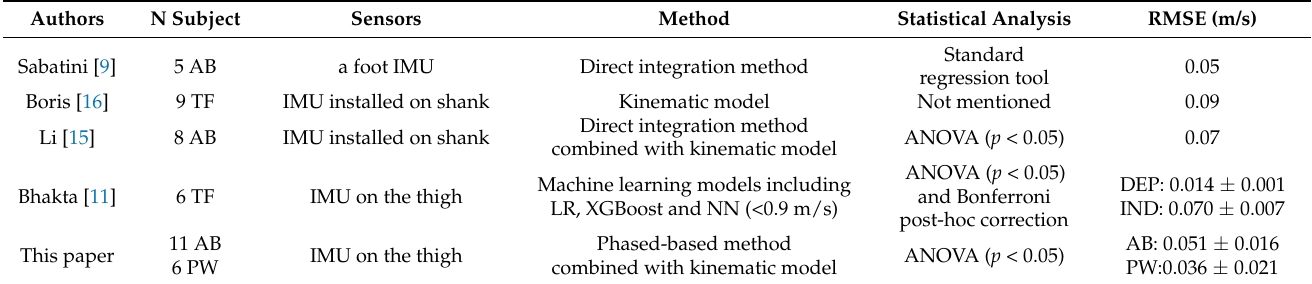
Table 1. Related papers and experimental results of walking speed estimation methods.